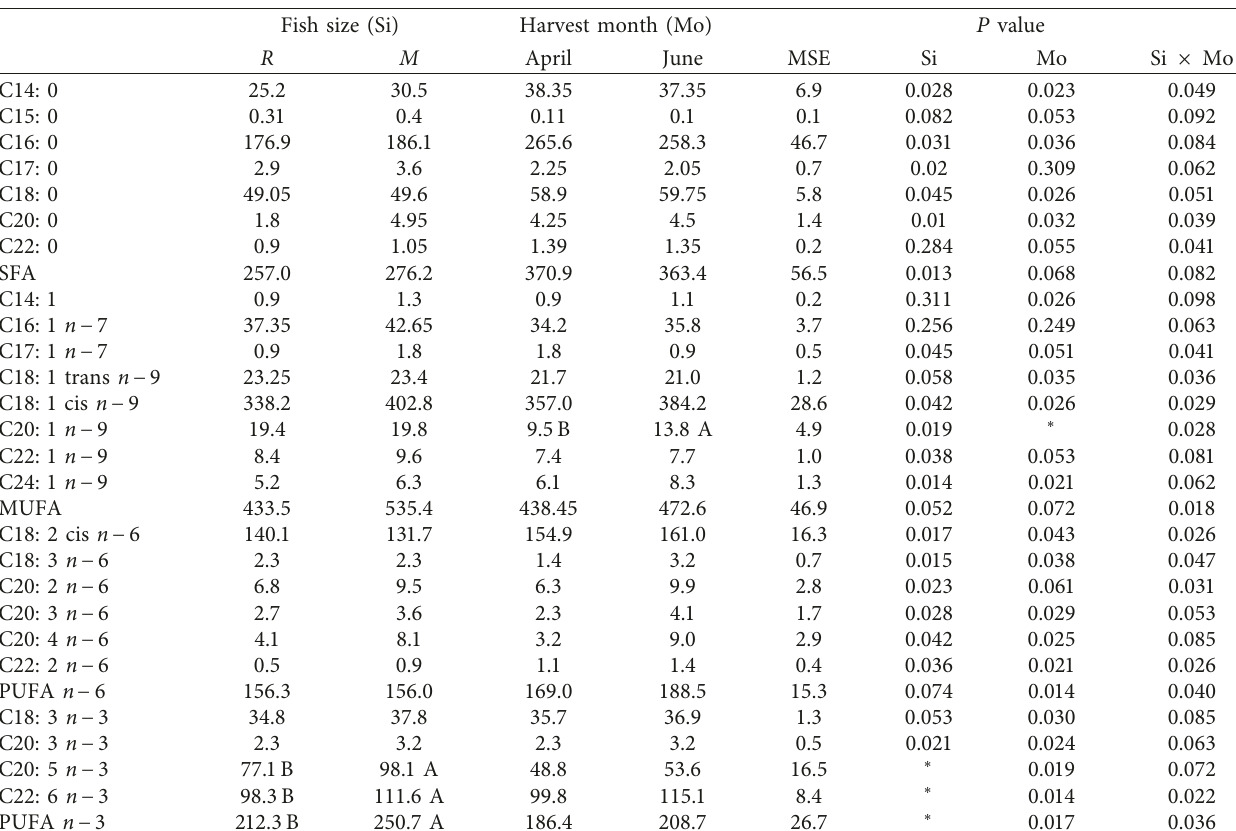
Table 3: Fatty acid profile (mg/100 g flesh) determined in the fillet of ABF gilthead sea bream according to fish size and harvest month. Fish size (Si) Harvest month